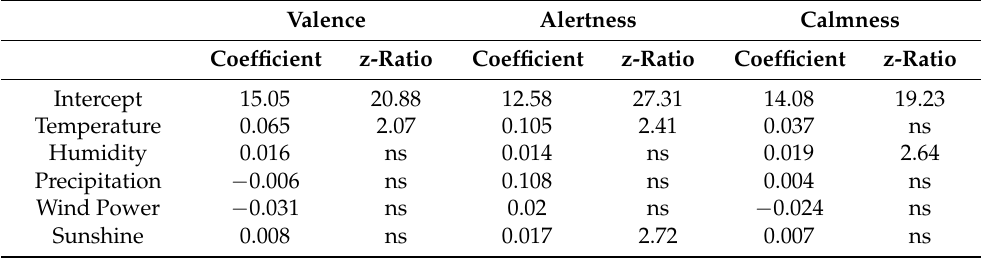
Table 2. Relation between several domains of momentary affect (valence, alertness, calmness) and different environmental (weather)